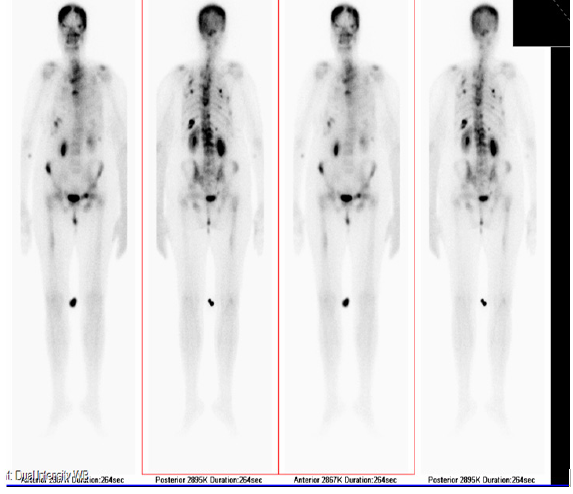
Figure 2: A case of breast cancer with limited